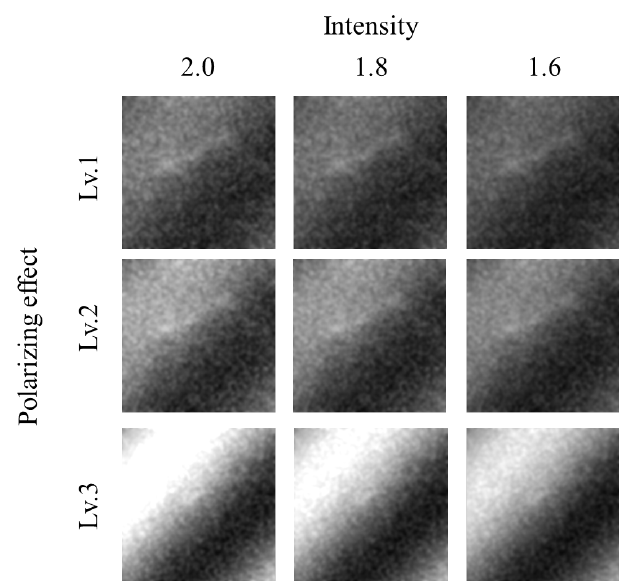
Figure 12. Sample images according to polarizing and intensities.